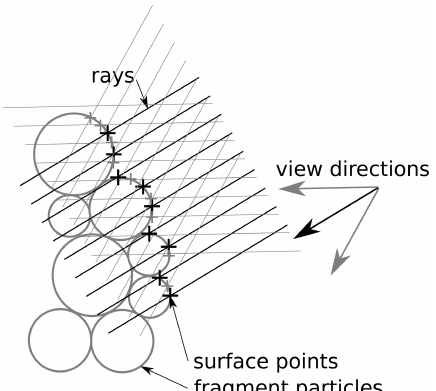
Figure 2. Simplified 2-D sketch of the ray-casting method. The gray particles are assumed to belong to the same fragment of the de- formed sample, and the black and gray crosses show the fragment surface calculated from the line–particle intersections using multi- ple view directions. Black lines and the black arrow show primary view direction; light gray lines and arrows show additional view directions at a 30 ◦ angle to the primary direction.